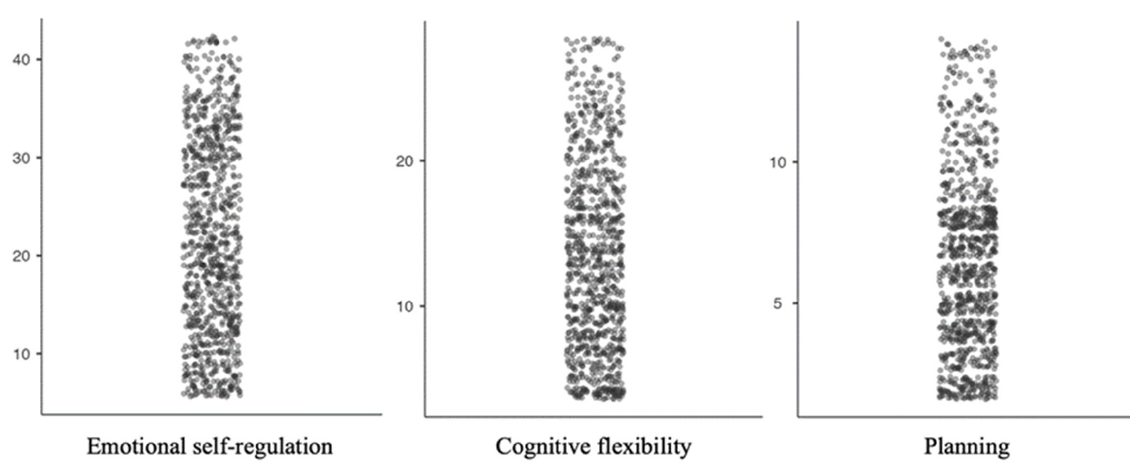
Figure 3. Box plot. Distribution of the sample in the emotional self-regulation, cognitive flexibility, and planning domains of executive functioning.